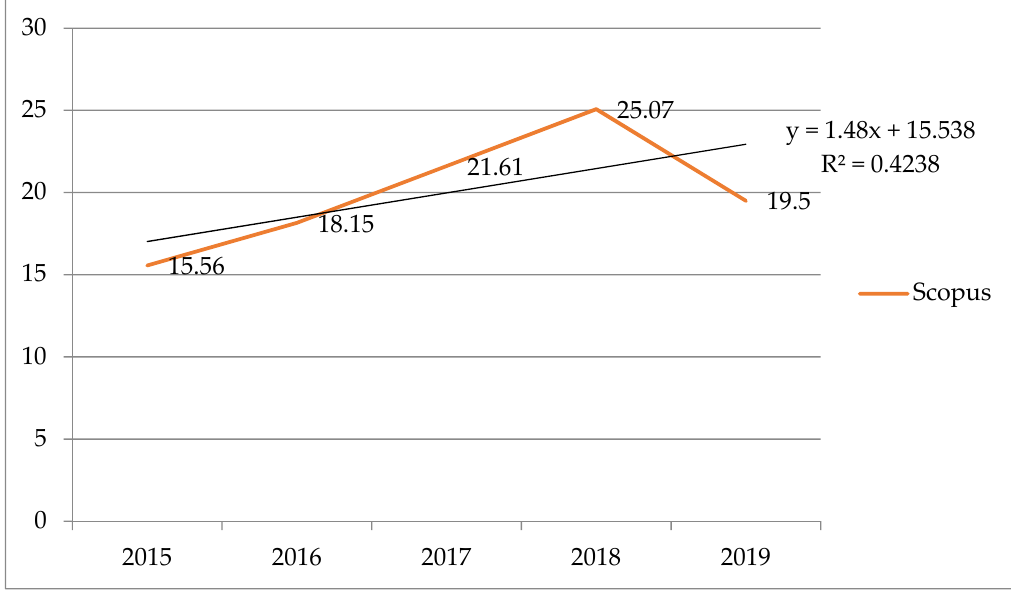
Figure 3. Diachronic production of the scientific production indexed in the Scopus database.